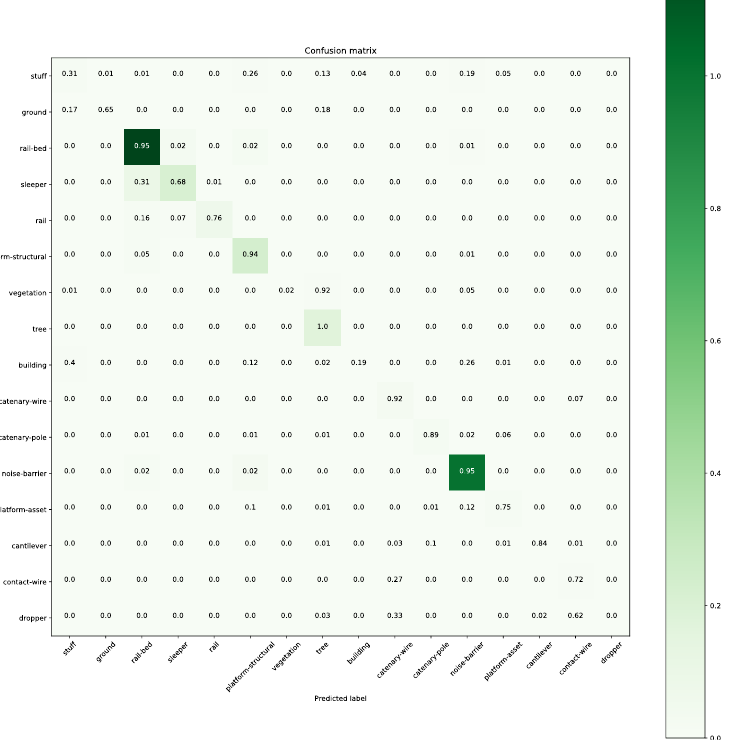
Figure A5. Confusion matrix for the 40% validation for step 70. The colour depicts the actual number of points in the validation